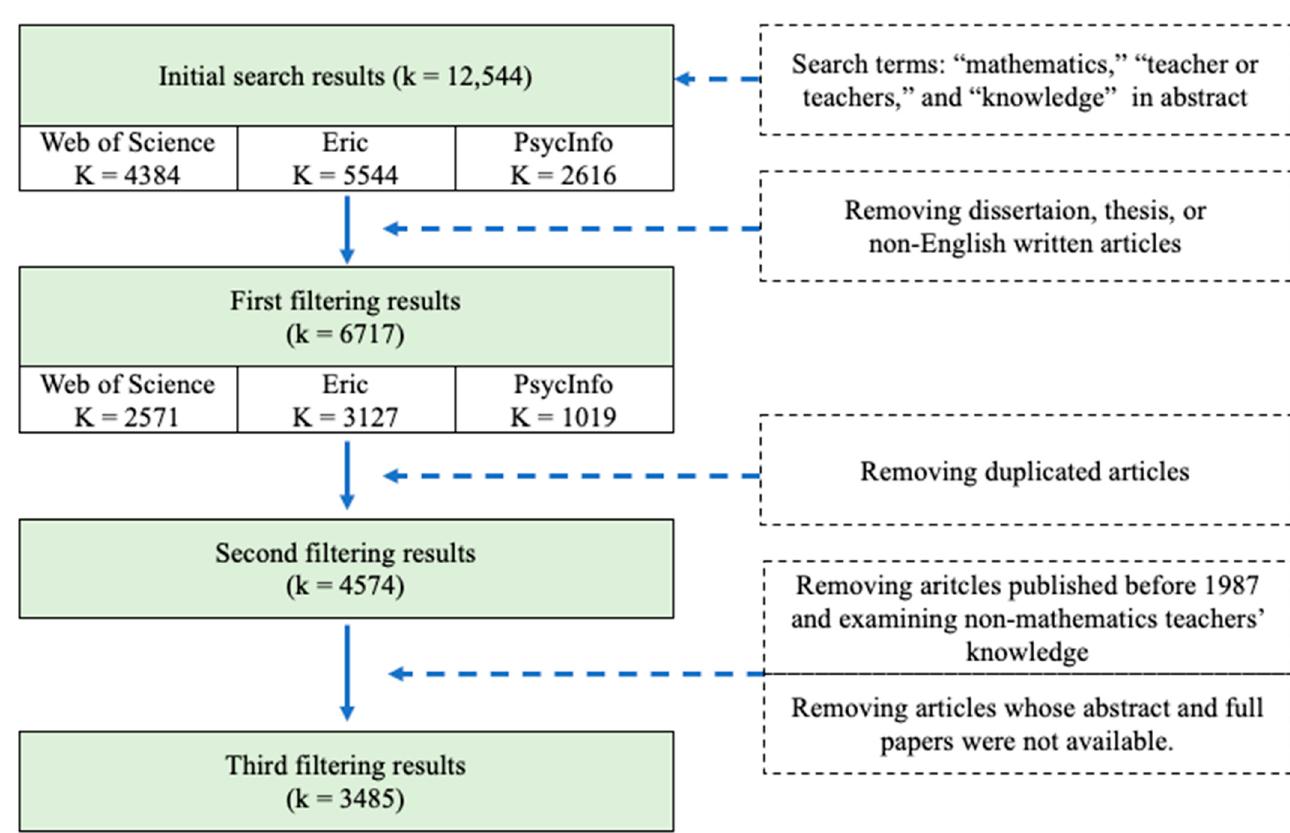
Figure 2. Data selection process.